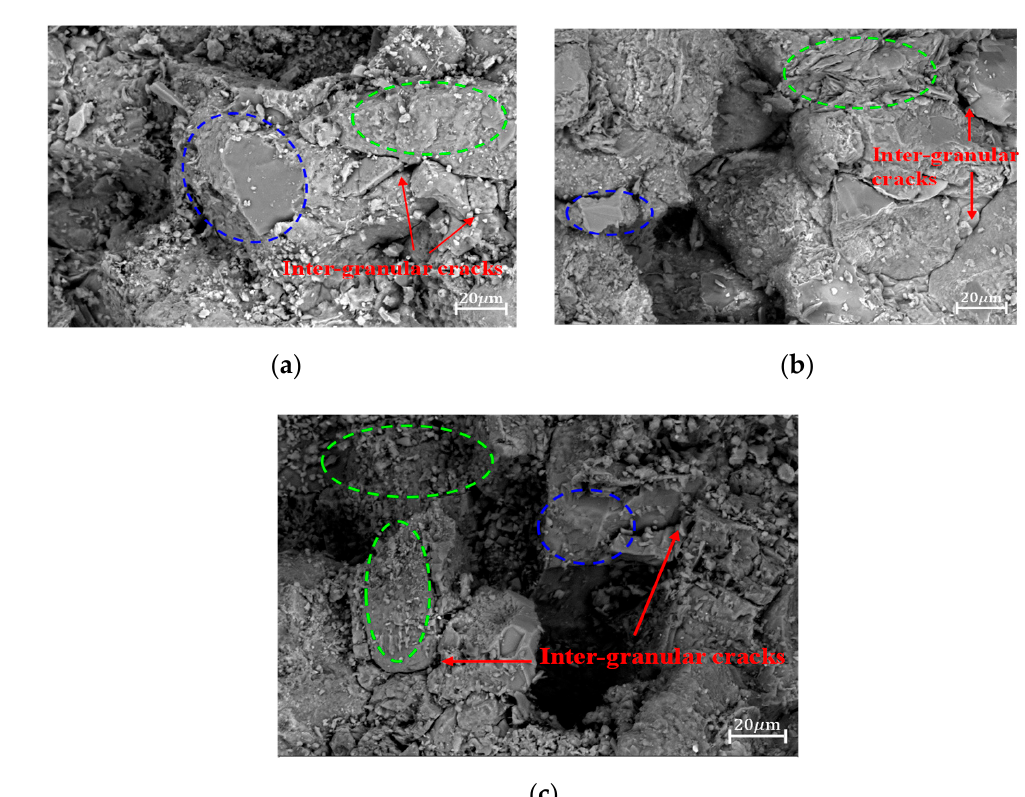
Figure 8. SEM images of the fractured surfaces: blue marks and green marks represent transgranular fracture and intergranular fracture, respectively. ( a ) ANSCB − I; ( b ) ANSCB − II; ( c ) ANSCB − III.